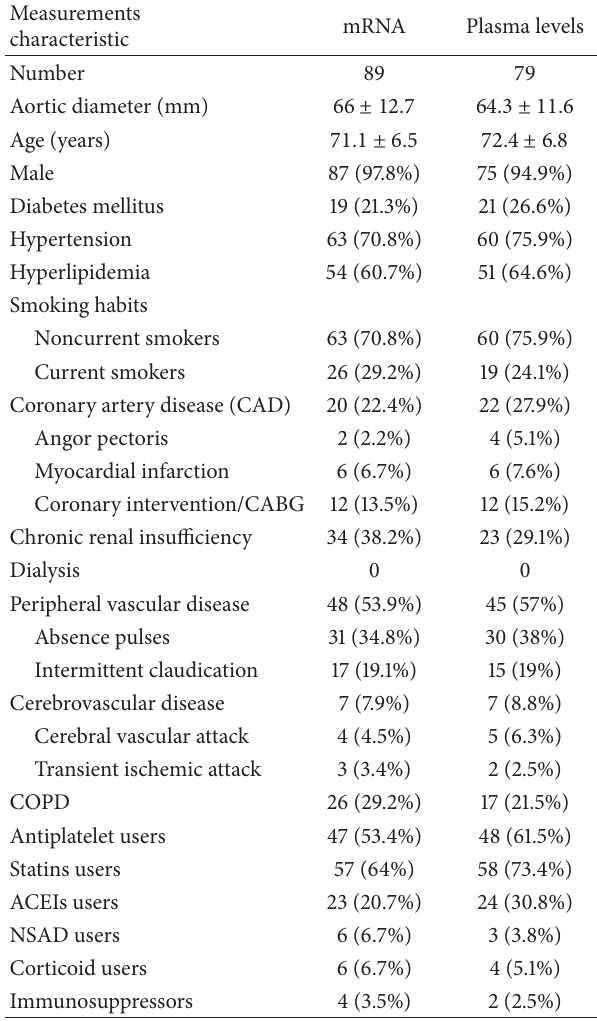
Table 1: Clinical characteristics of individuals with AAA included in the study, demographics, and risk